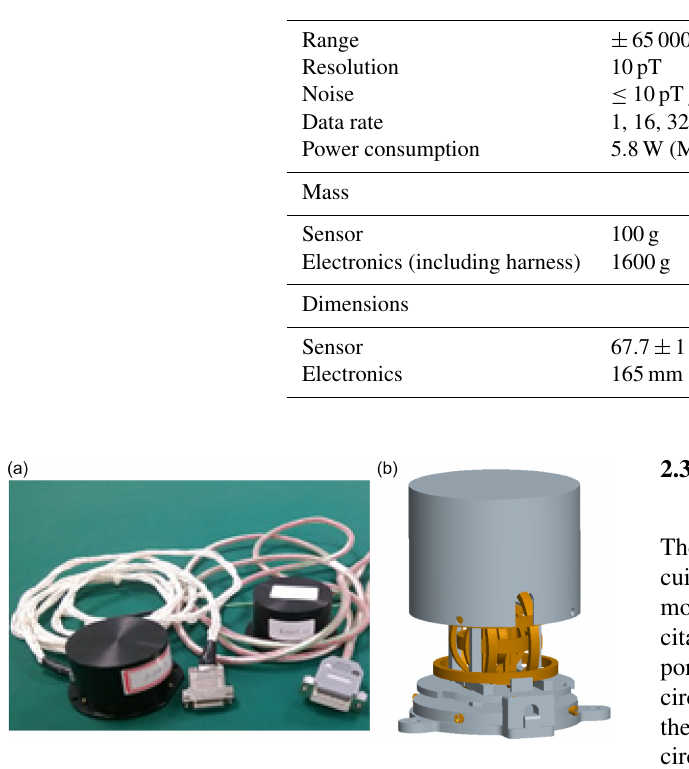
Figure 2. A real sensor picture (a) and structure design diagram of the sensor (b)